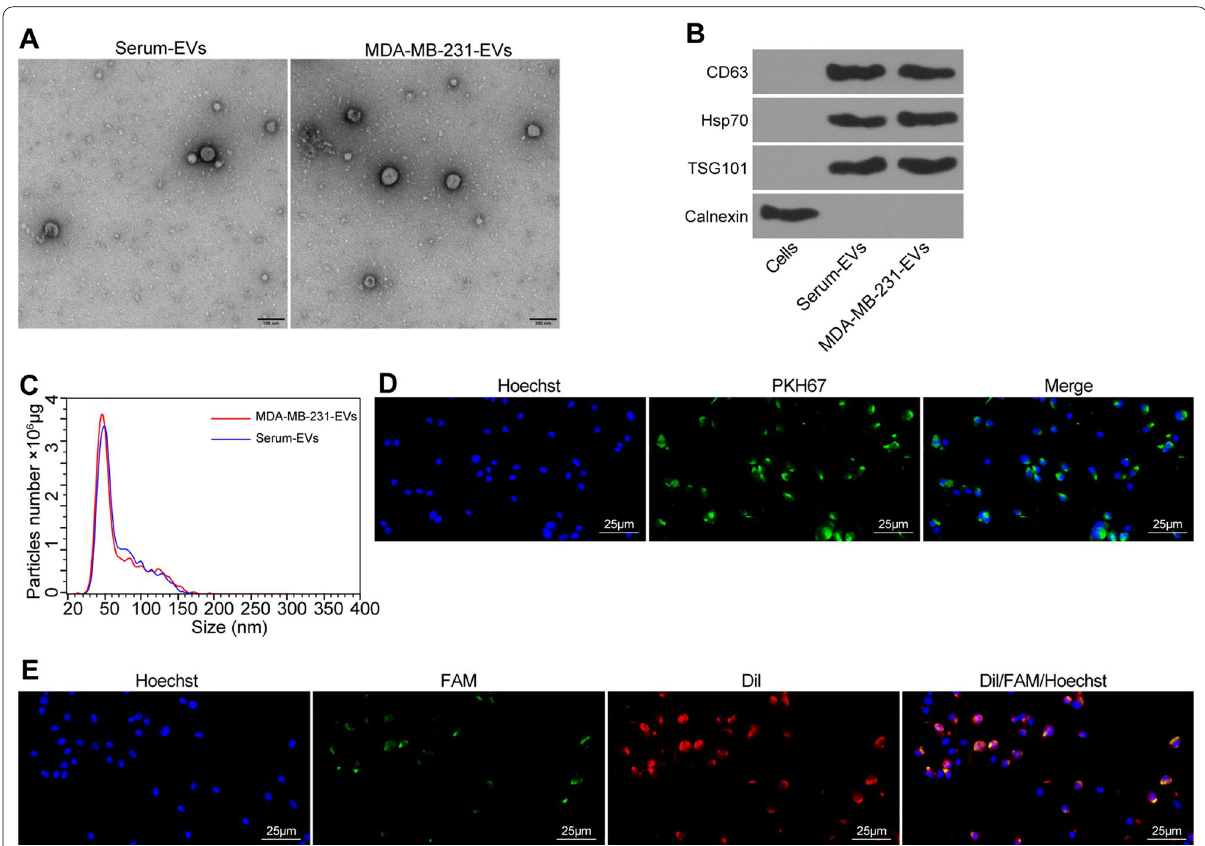
Fig. 3 EVs derived from breast cancer cells transfer miR-182-5p to HUVECs. A Morphological characteristics of EVs derived from the serum of breast cancer patients and MDA-MB-231 cells under a TEM; B Expression of EV marker proteins CD63, Hsp70, TSG101 and Calnexin detected by Western blot analysis; C Diameter of EVs detected by Nanosight Nanoparticle Tracking Analyzer; D Uptake of EVs in HUVECs under a confocal microscope, blue: Hoechst staining, green: PKH67-labeled EVs; E miR-182-5p transfer by EVs to HUVECs detected by immunofluorescence (green fluorescent labeled miR-182-5p, red fluorescent labeled EVs, blue fluorescent represented the nucleus). The experiment was conducted three times